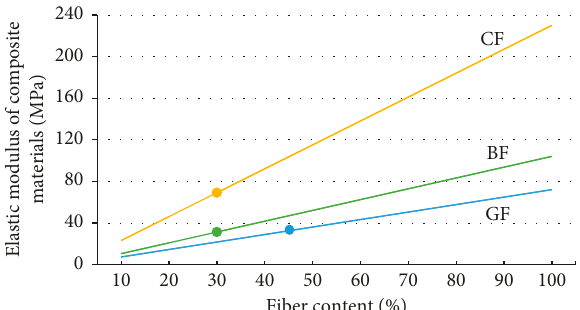
Figure 11: Moduli and fiber contents of unidirectional continuous composites.